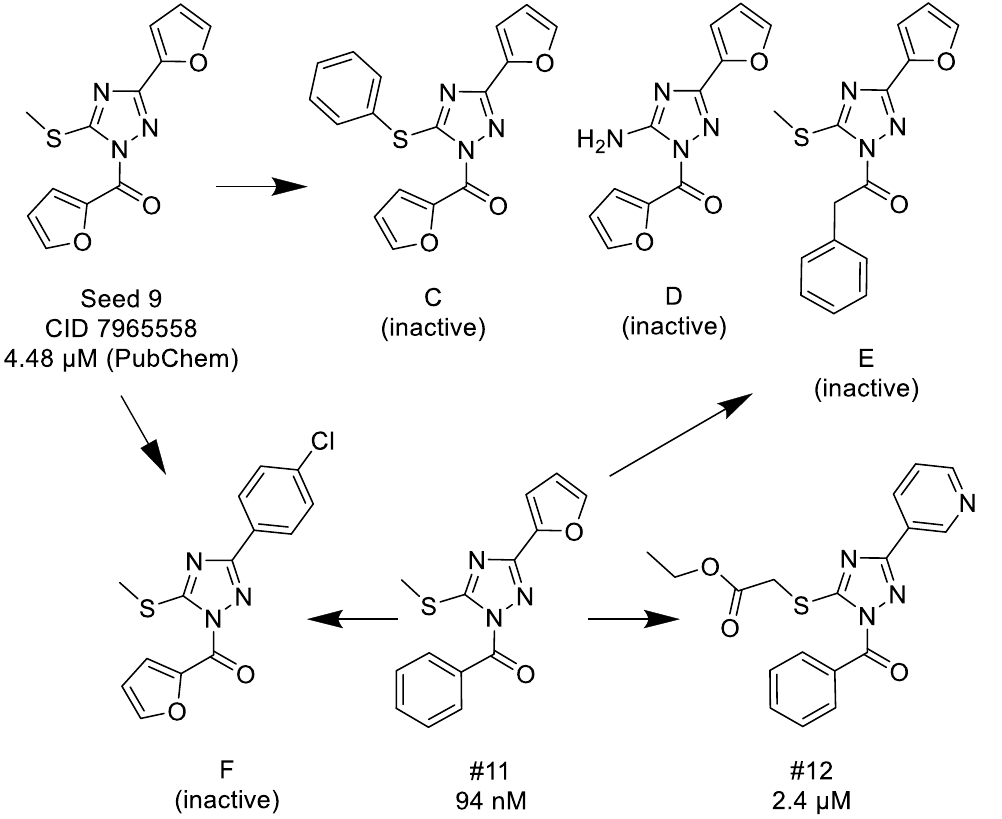
Scheme 6. Examples of the 1,2,4-triazoles structure–activity